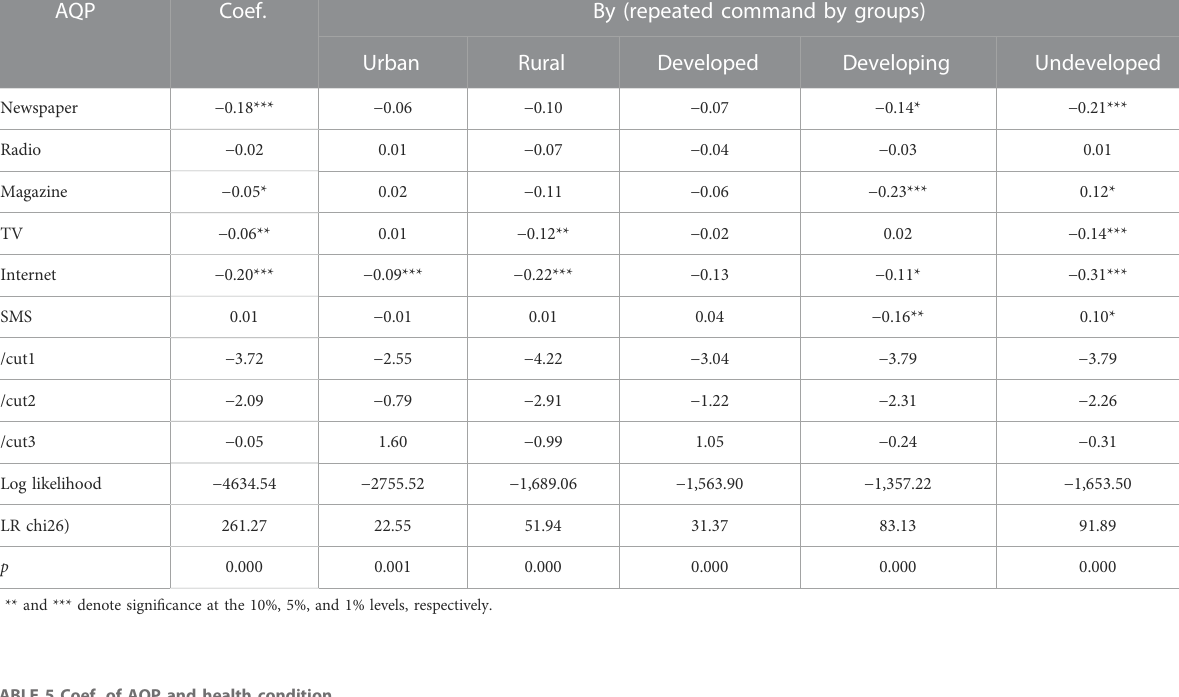
TABLE 4 Coef. of AQP and media contact. AQP Coef. By (repeated command by groups) Urban Rural Developed Developing Undeveloped Newspaper